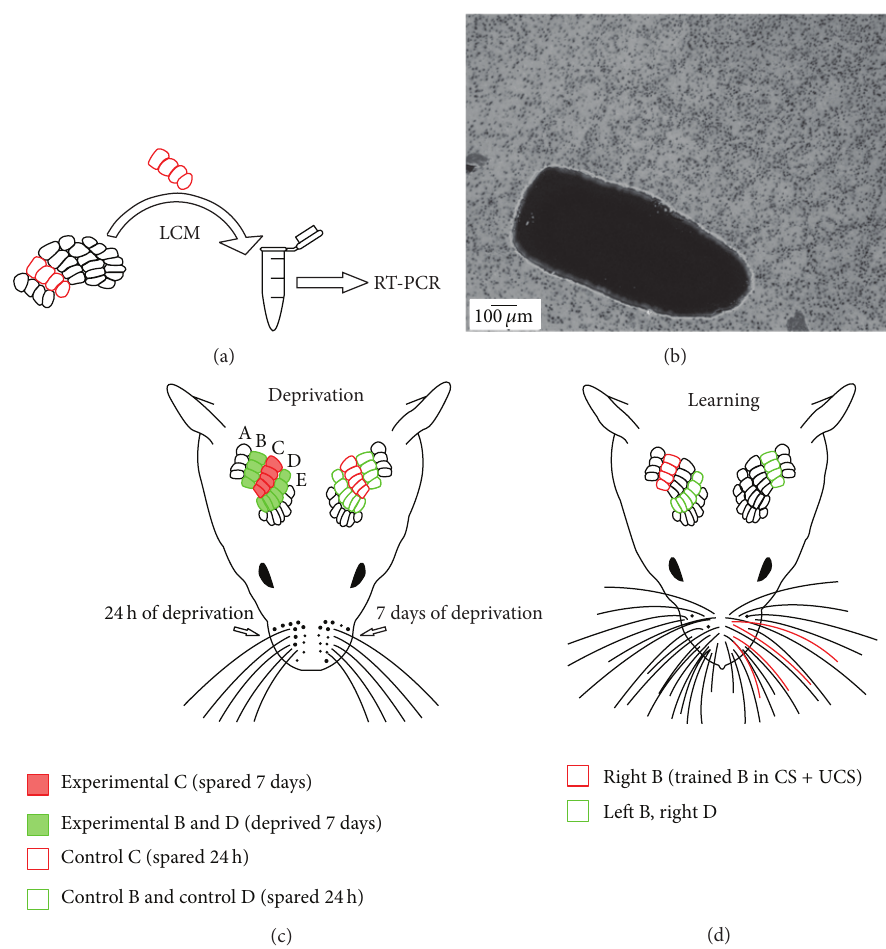
Figure 2: (a) Single rows of barrels are microdissected from Nissl-stained sections. RNA from dissected tissue is extracted and processed for RT-PCR. (b) Nissl-stained section with row B dissected out. Neighbouring row C is left intact. ((c), (d)) Rows of barrels microdissected in deprivation (C) and sensory conditioning (D) experiment. Microdissected barrels are colored in green and red. Legend below the scheme explains terminology used in the text for description of particular